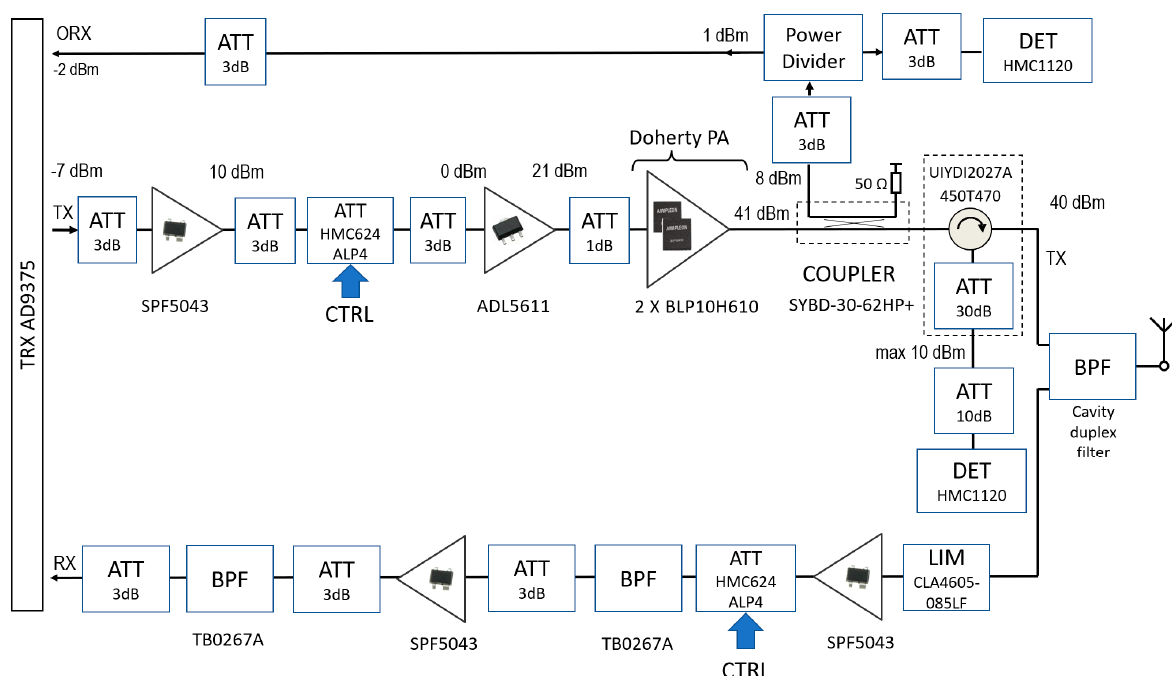
Figure 7. Block diagram of the single RF channel of the B31 RF front-end.